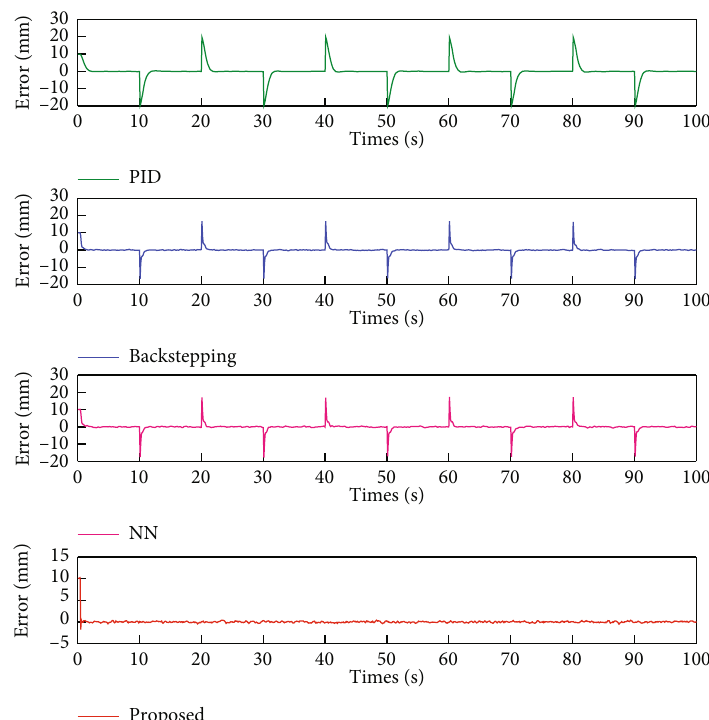
Figure 12: Tracking error of square